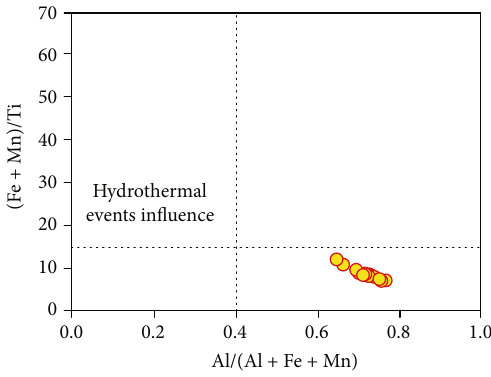
versus ( Al O + K O + Na O ) for paleoclimate [56] in the Chang 7 3 black shale. 2 3 2 2 2